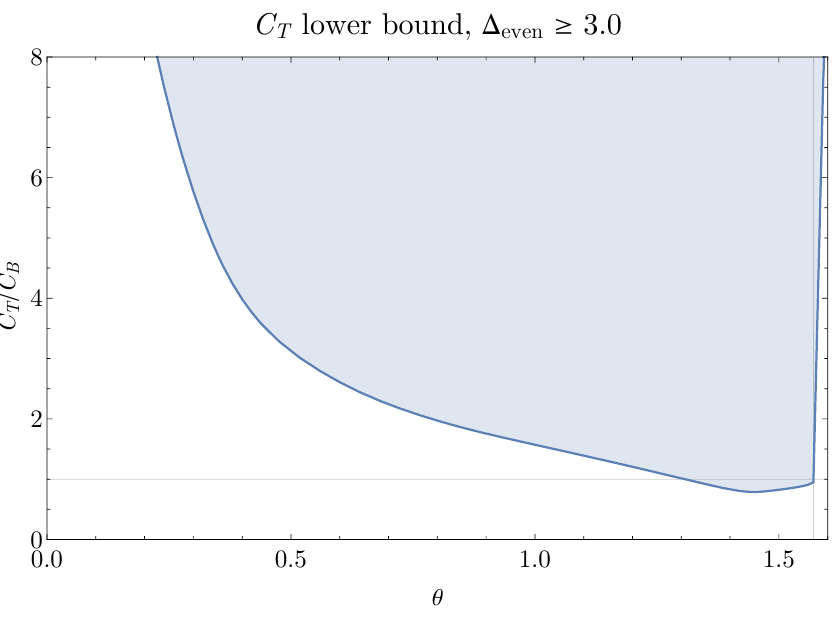
Figure 3 . A lower bound on C T as a function of (cid:18) in 3d CFTs with no relevant parity-even